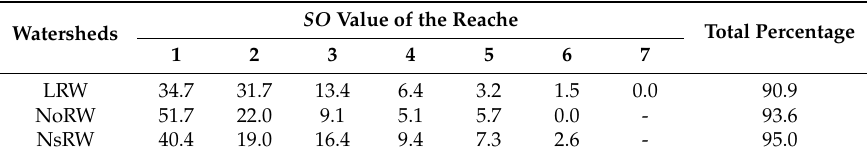
Table 4. The ratio of the number of landslide beside the reaches with different stream order ( SO ) to the total number of landslide induced by typhoon events in the three watersheds.